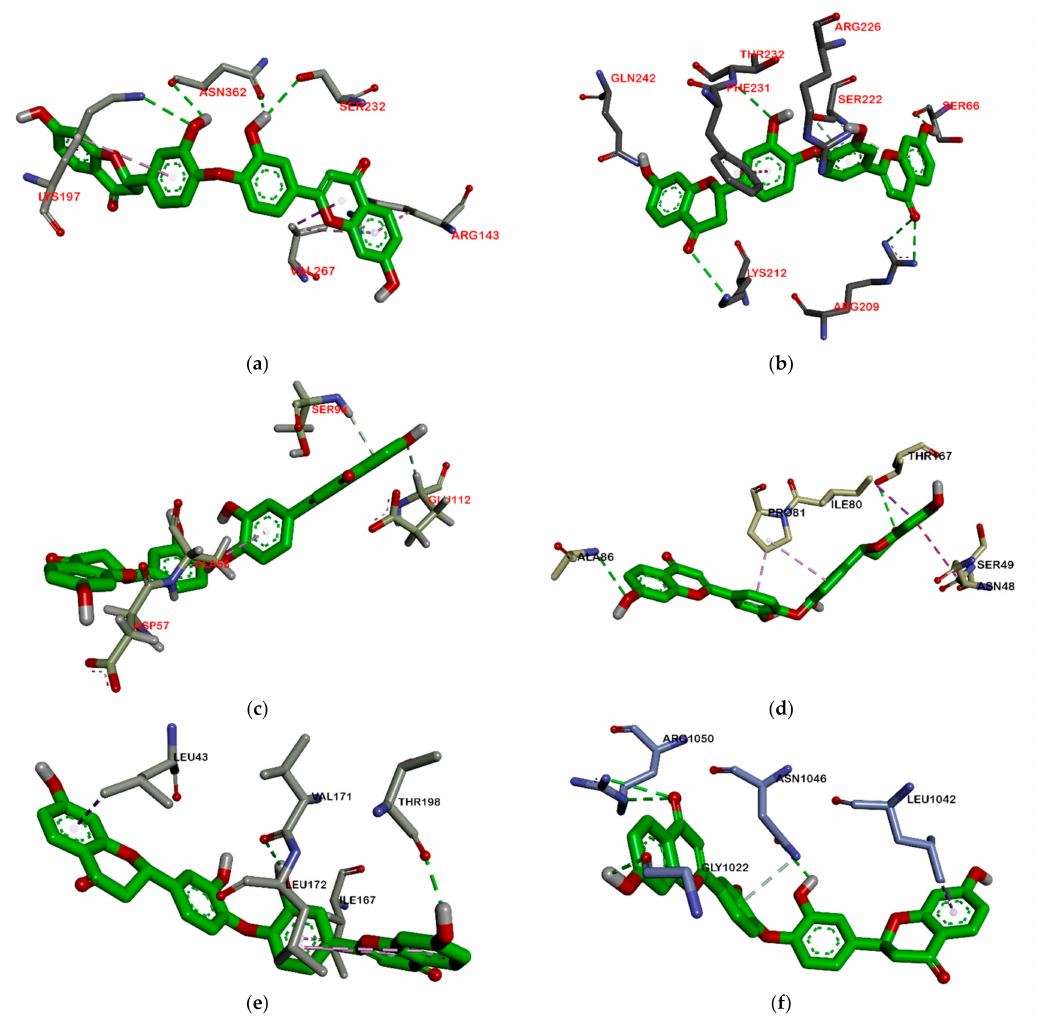
Figure 7. Interaction biflavonoid with PBP ( a ), MurB ( b ), SrtA ( c ), DNA gyrase ( d ), RNA polymerase alpha ( e ), RNA polymerase beta ( f